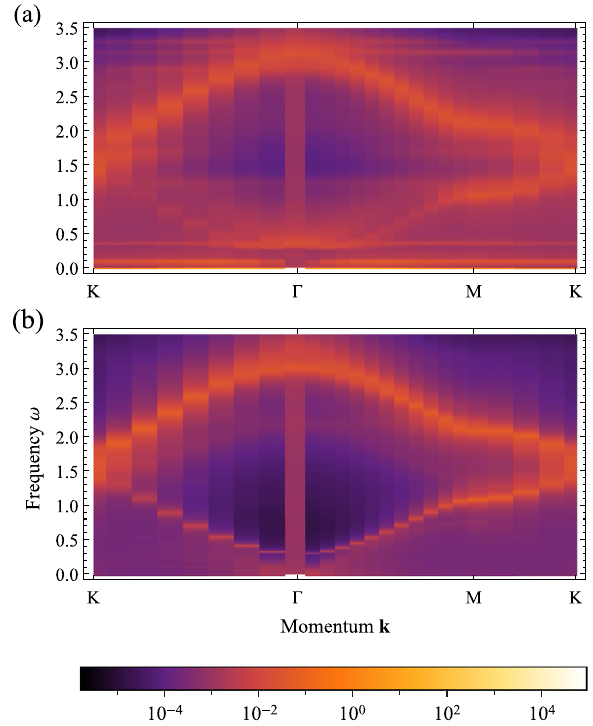
Fig. 8 Dynamical spin structure factor. The data is obtained at φ = π /4, L = 24, and plotted at T / S 2 = 0.02. a The fi eld h / S = 0.95 gives rise to a dilute vortex liquid. b In the fully polarized state at h / S = 1.0 only the two conventional magnon bands are visible. Note that the leading ω = 0 divergence at the Γ point gives rise to an unphysical tail at ω > 0, which is a numerical artifact of the Fourier transform over a fi nite time interval (see the Methods section for